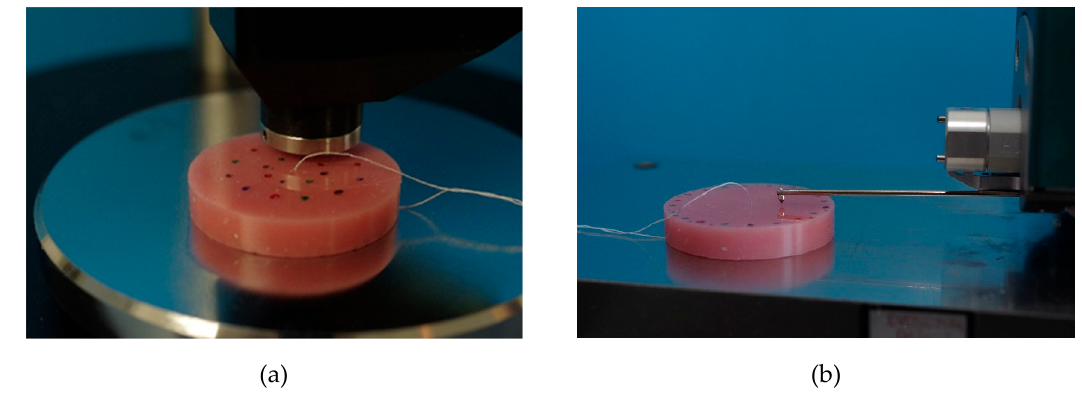
Figure 4. Shore A hardness testing with a digital durometer (a) , surface roughness testing with contact profilometry (b) .